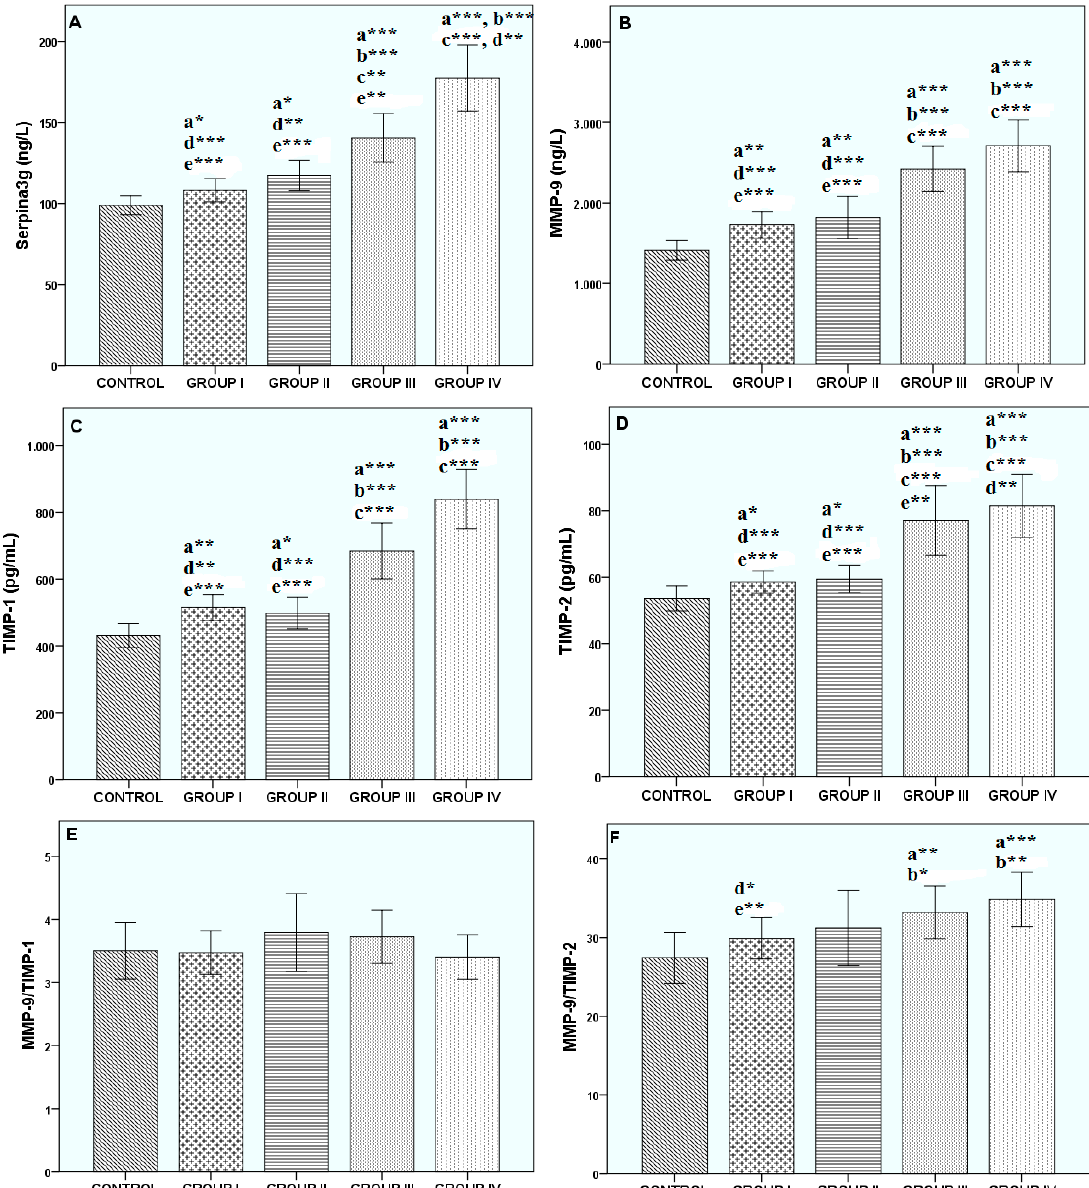
Figure 1. The changes in plasma ( A ) serpina3g, ( B ) matrix metalloproteinase-9 (MMP-9), ( C ) tissue inhibitor of metalloproteinase-1 (TIMP-1), ( D ) tissue inhibitor of metalloproteinase-2 (TIMP-2), ( E ) MMP-9/TIMP-1, and ( F ) MMP-9/TIMP-2 of all subjects. * p < 0.05, ** p < 0.01, *** p < 0.001. a vs. Control, b vs. group I, c vs. group II, d vs. group III, e vs. group IV.